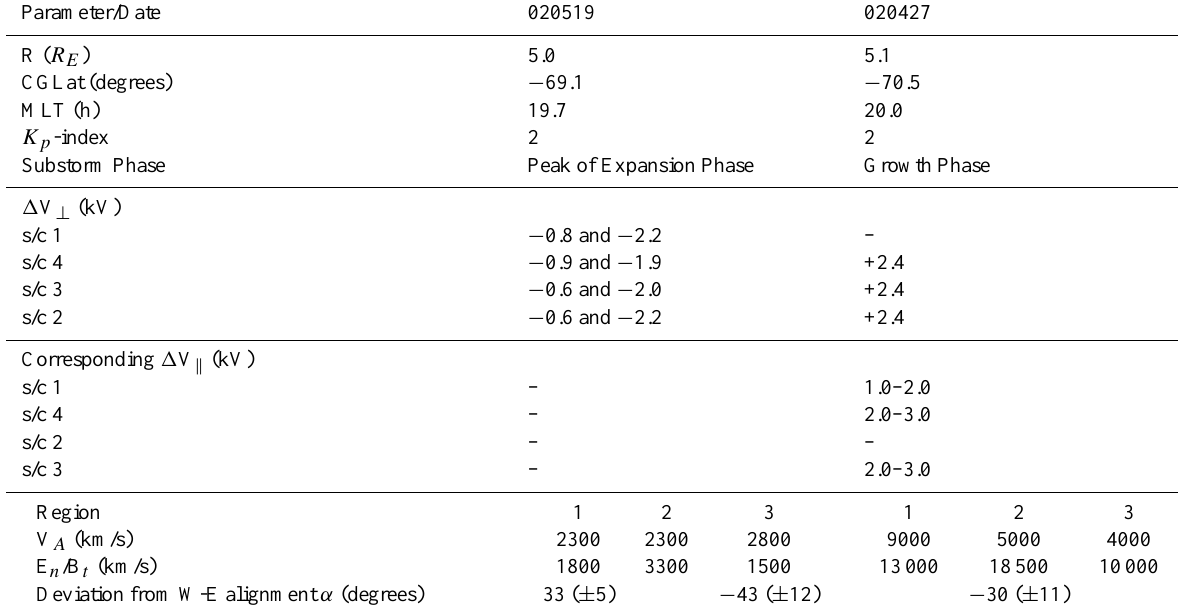
Table 1. Summary of the events of 27 April and 19 May 2002. Positive (negative) α corresponds to anti-clockwise (clockwise) rotation of the current sheet from east-west alignment. The different α given for 19 May 2002 corresponds to the two different regions of spatial variations, see the